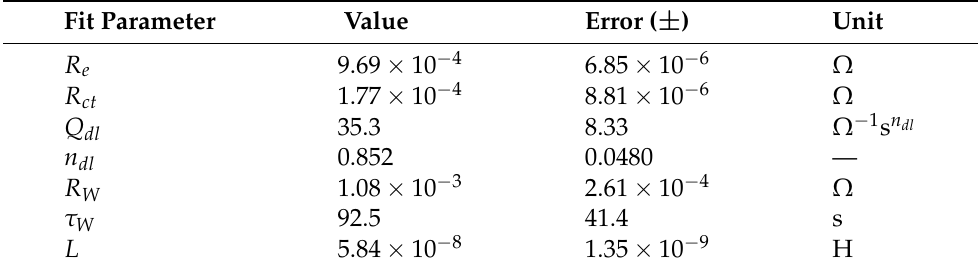
Table 2. Fitted values obtained from equivalent-circuit-model-based parameter extraction from EIS data collected from module 1 of 13 at 60% SoC, with modification of ECM in Figure 3. This fit is presented graphically in Figure 4.